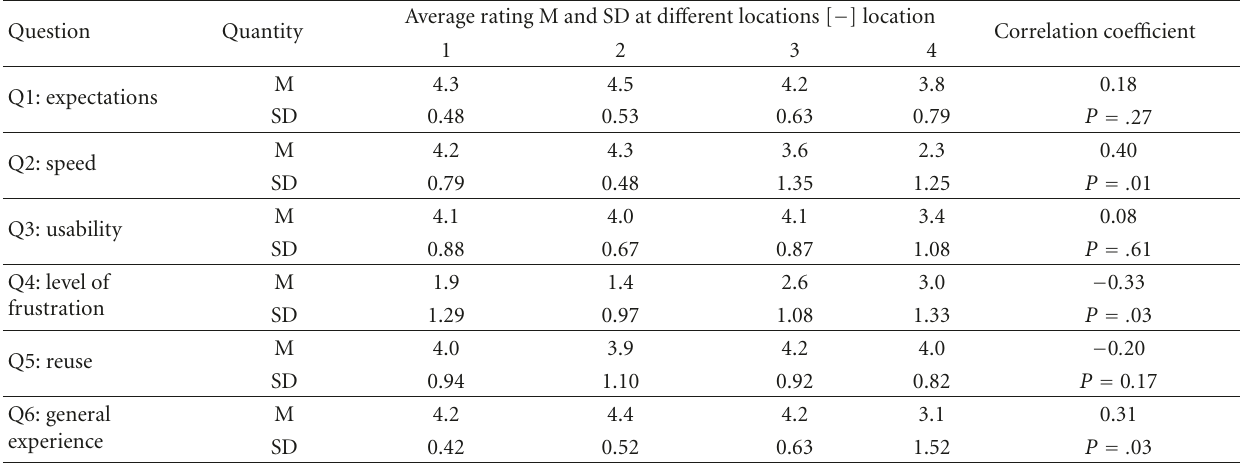
Table 2: Exponential regression models for rating Q2, Q4, and Q6. R 2 = 1-(Residual Sum of Squares)/(Corrected Sum of Squares) Exponential formula R 2 = 0.36